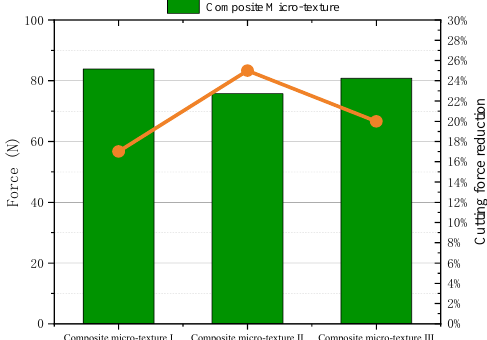
Figure 11. Cutting force of composite micro−texture tool.